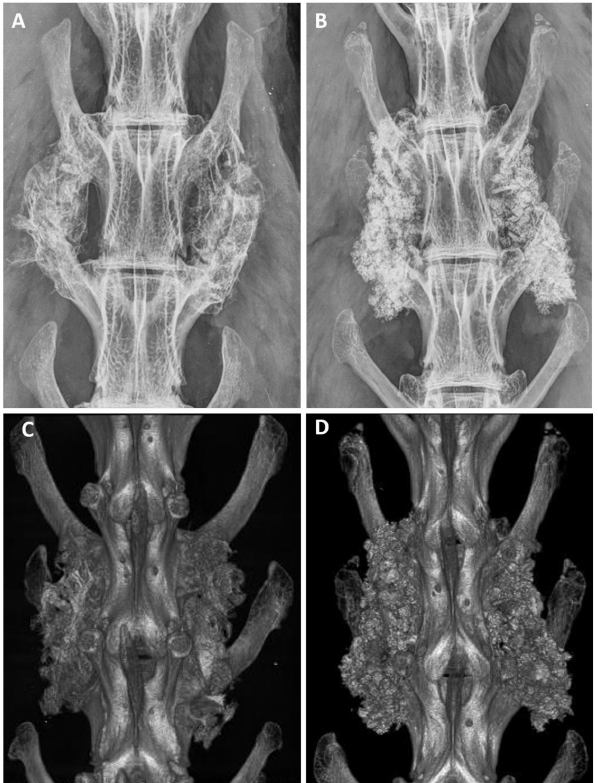
Figure 4. Representative examples of Faxitron radiographs taken after 12 weeks for ( A ) ABG and ( B ) BCP-EP/ABG. Representative examples of 3D micro-CT reconstructions taken after 12 weeks for ( C ) ABG and ( D ) BCP-EP/ABG. The Faxitron radiographs and micro-CT reconstructions show the presence of graft material bridging the intertransverse process space of the treated levels in all